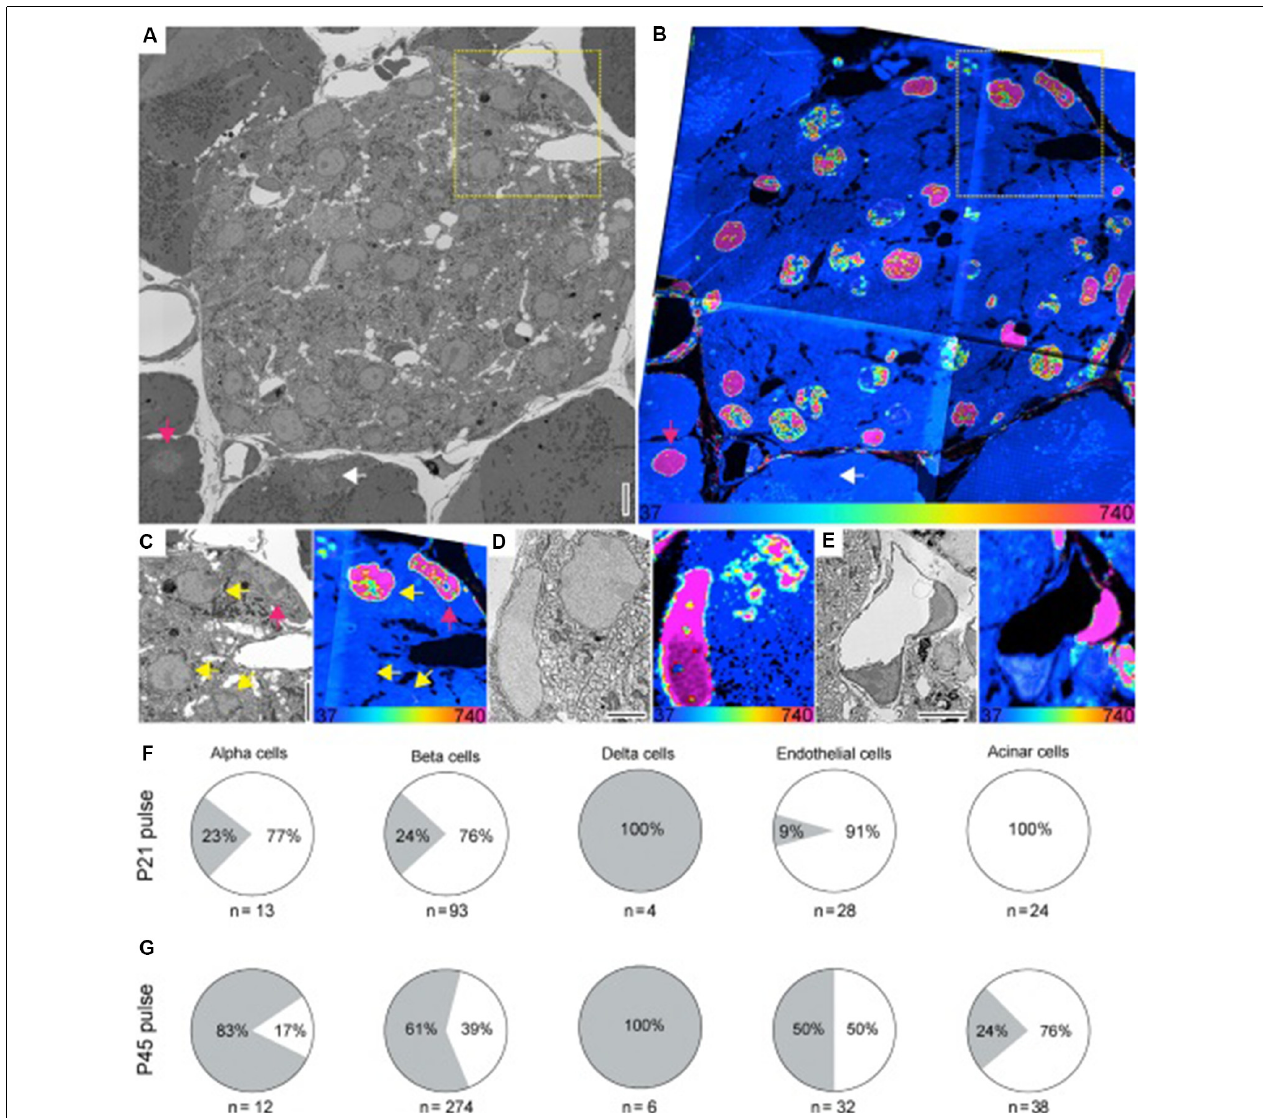
FIGURE 6 | (A,B) SEM (A) and MIMS (B) of a cross-section of the islets of Langerhans (pancreas). Old and young acinar cells are indicated by the pink and white arrow, respectively. Yellow dotted box highlights cells shown in (C) . (C) Enlarged view of boxed region in (A) and (B) . SEM and MIMS of beta cells (yellow arrows) and an old alpha cell (pink arrow). (D) An old delta cell (left) next to a younger beta cell (top right). (E) SEM and MIMS of a young (bottom) and an old (top right) endothelial cell. Old pancreatic stellate cells are seen in the top and lower right corners. (F) Relative turnover in percentages of cells that are as old (gray) or younger (white) than L2 neurons from 15 N-SILAM P21 mouse chased for 26 months. (G) Same as in (F) , but from a 15 N-SILAM P45 mouse chased for 18 months. The total number of cells analyzed for each cell type is listed underneath each pie chart. At the bottom of the MIMS images, the heatmap shows the 15 N/ 14 N x 10 4 and scaled with an HSI. Scale bars: 5 µ m (A,C,E) and 2.5 µ m (D) . In this case, the 15 N label represents “older” cells. Thus, the 15 N label can be used to identify long-lived cells in the pancreas, and using a pulse-chase experiment, shows the period during which cellular turnover is most likely to occur. Reprinted from Arrojo e Drigo et al. (2019) with permission from